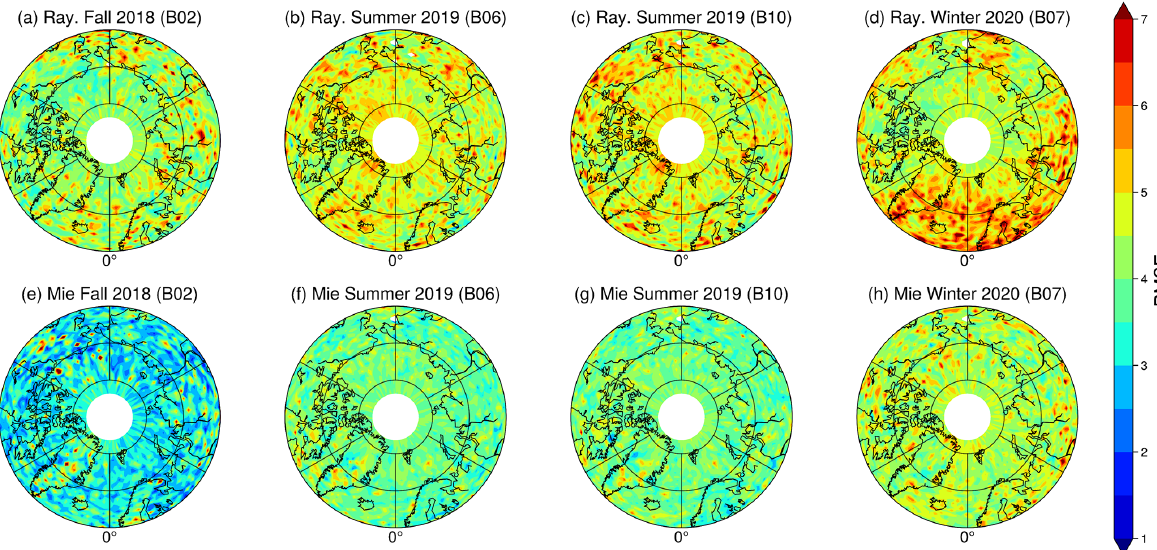
Figure 11. RMSD of Aeolus and ECCC-B vertical HLOS wind profiles for selected lower-atmospheric regions (Rayleigh T and Mie